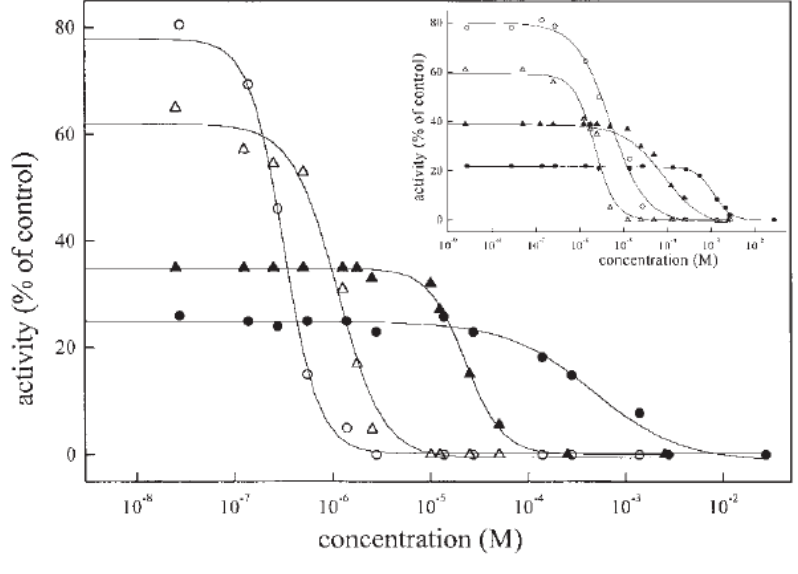
Figure 3. The theoretical curves for inhibition of high (open symbols) and low (solid symbols) affinity Na + ,K + -ATPase isoenzymes induced by gitoxin and digoxin (inset). Circles—human ghosts membranes; up triangles—commercial porcine cerebral cortex. Reproduced from